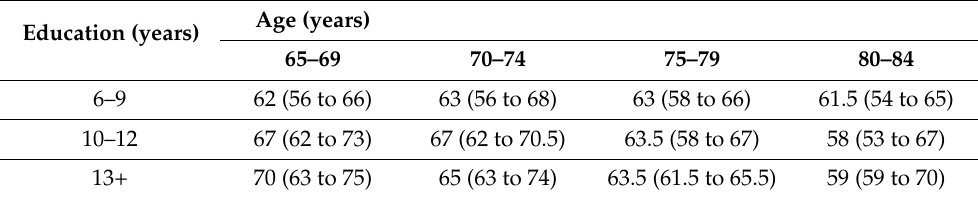
Table 5. Total Quick Mild Cognitive Impairment (Q mci -J) screen median scores (IQR) by age and education based on with sMMSE-J scores ≥ 27 for those without symptoms of cognitive impairment or suggestive medical conditions or medications (n =